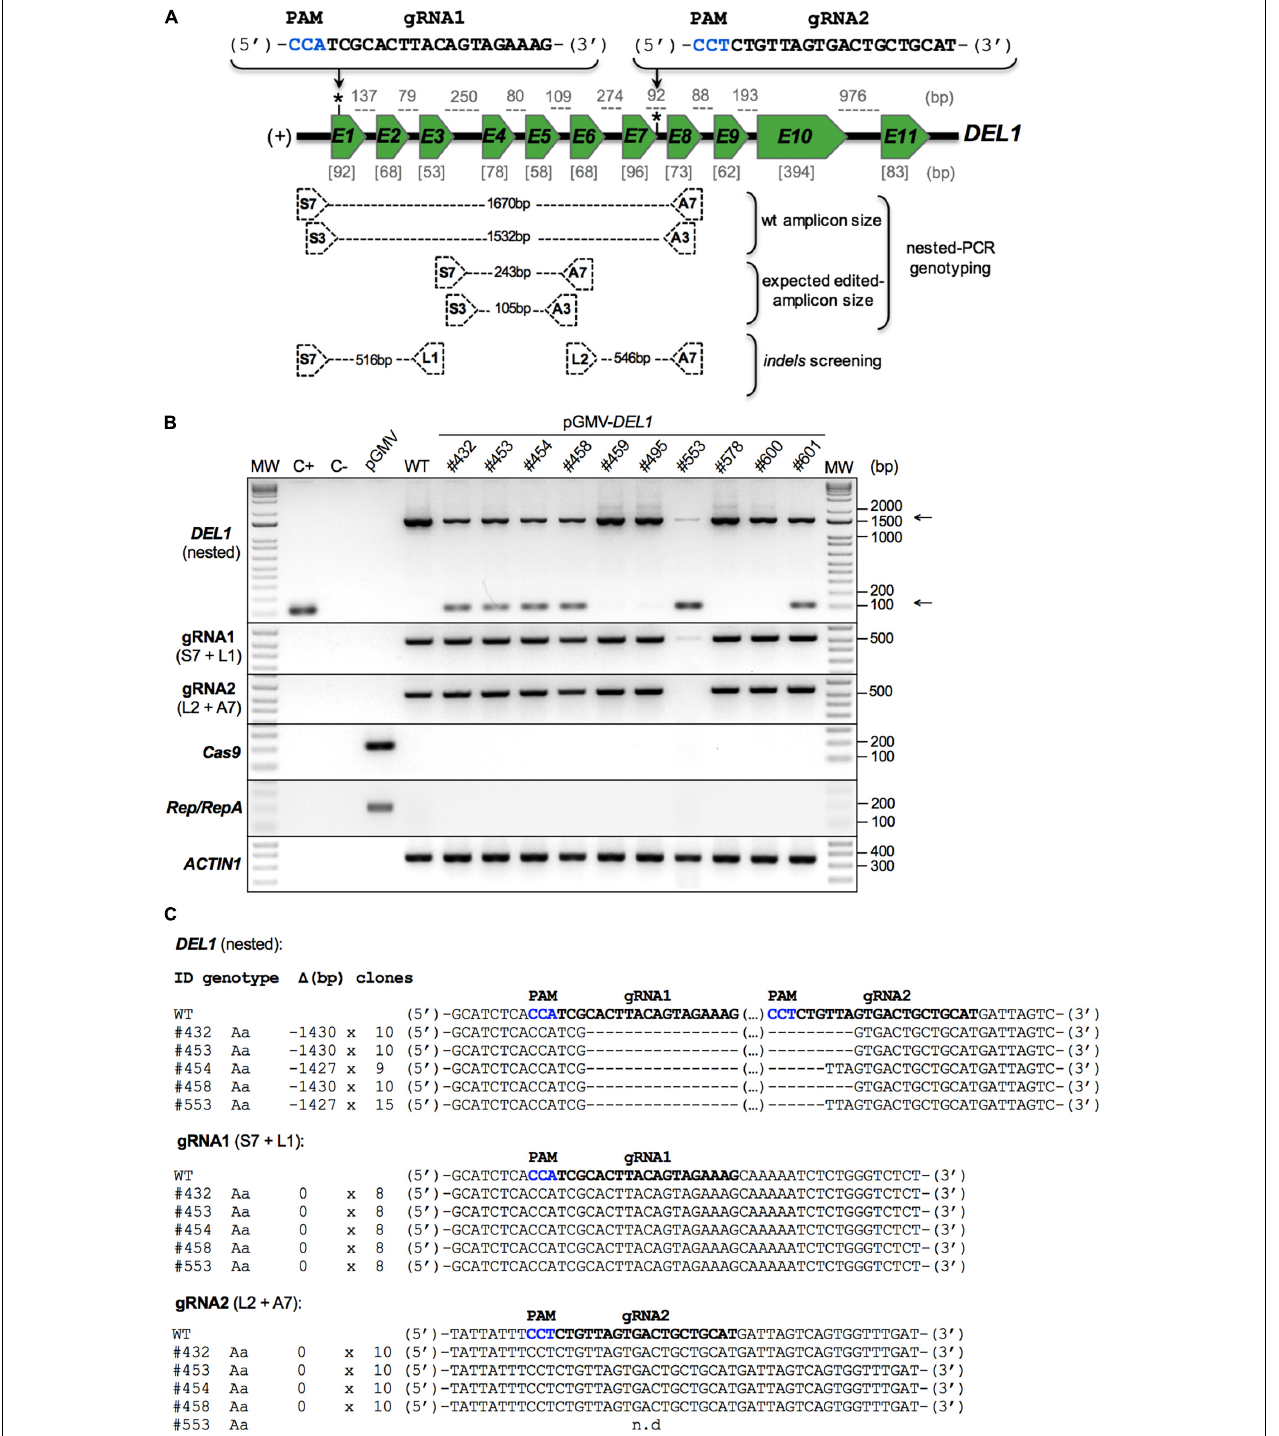
FIGURE 4 | Editing in the DEL1 gene of ‘Thompson Seedless’ individuals regenerated from somatic embryo gene transfer experiments. Gene transfer experiments were performed in somatic embryos using Agrobacterium EHA105 strain harboring the pGMV- DEL1 vector. After 8 months, whole individuals began to be recovered and developed for further analysis. Genomic DNA was extracted from the leaves of the individuals for use in the VviDEL1 editing characterization. (A) The structure of the gene, the position of the gRNAs (*), and the location of the amplification primers (black dotted boxes) are shown as a schematic. Exon (green boxes) and intron (black line between exons) sizes (bp, base pair) are indicated in gray square brackets and gray dotted lines, respectively. The gRNAs sequences are shown in bold,